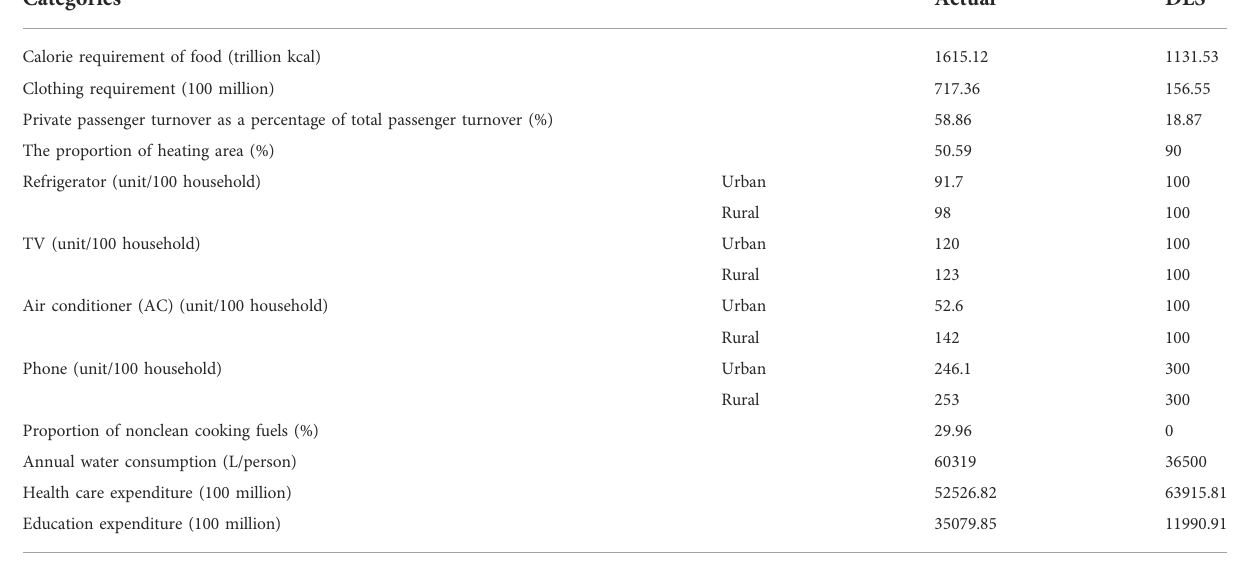
TABLE 1 Physical quantity under the actual situation and the DLS scenario in 2017.